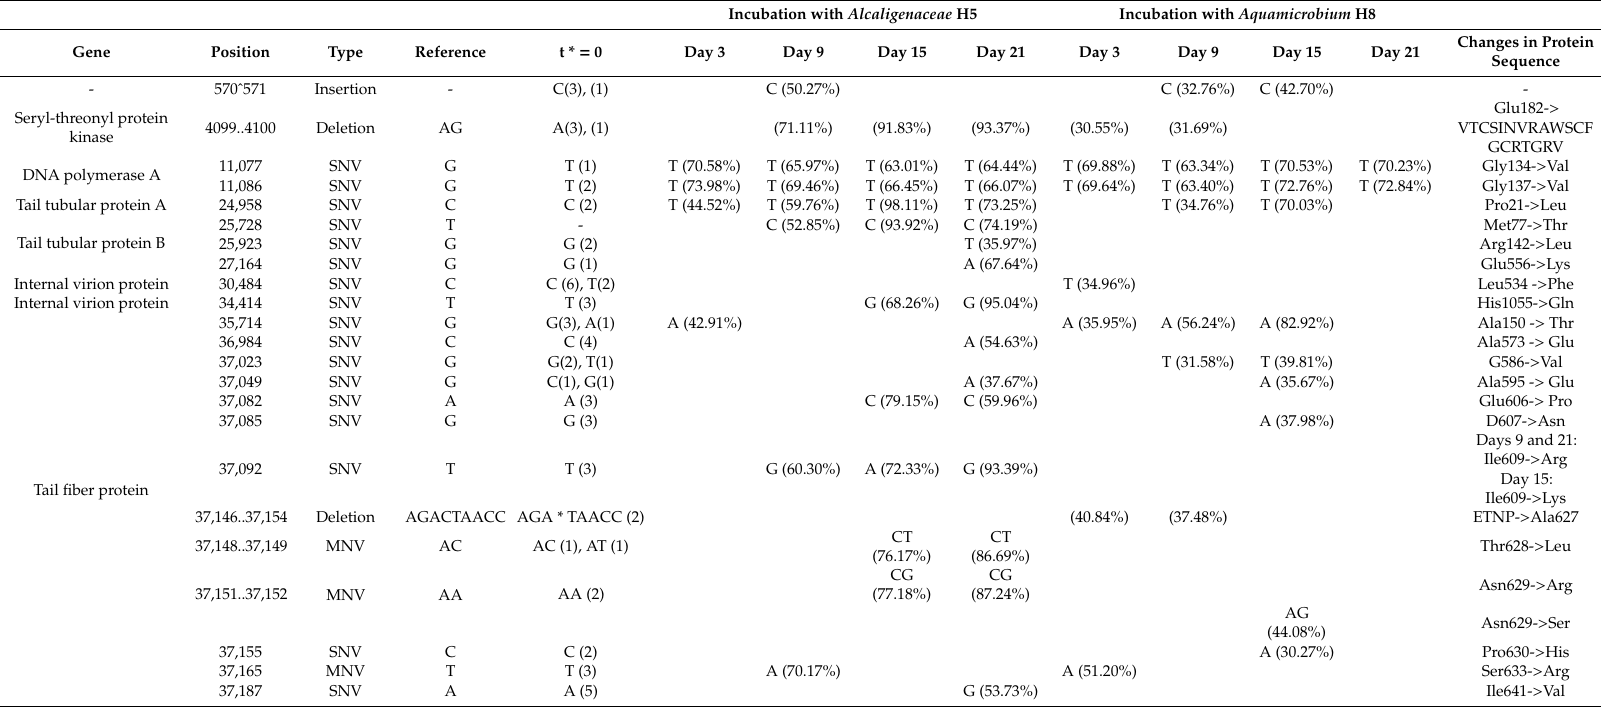
Table 2. Variants (with frequency above 30%) in the Aquamicrobium phage P14 genome over time when incubated with Alcaligenaceae H5 and when incubated with Aquamicrobium H8. Frequency is indicated in parentheses. Variant types: SNV—single nucleotide variant; MNV—multiple nucleotide variant; insertion—addition of a nucleotide; and deletion—removal of a nucleotide. t *—the nucleotides in mapped reads present at the beginning of the experiment; due to the low coverage, the number of mapped reads is given in